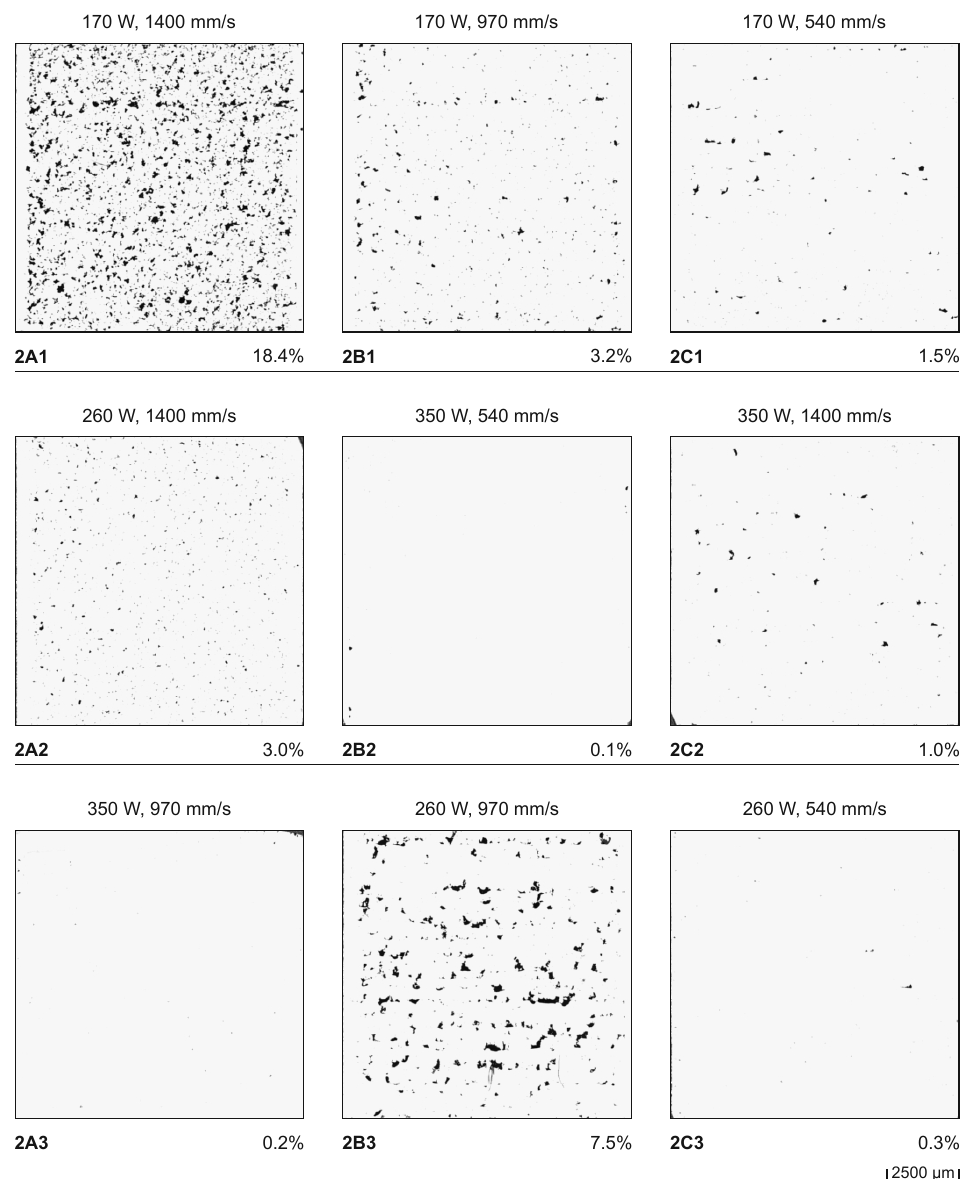
Figure A2. Display of porosity for the second replication of